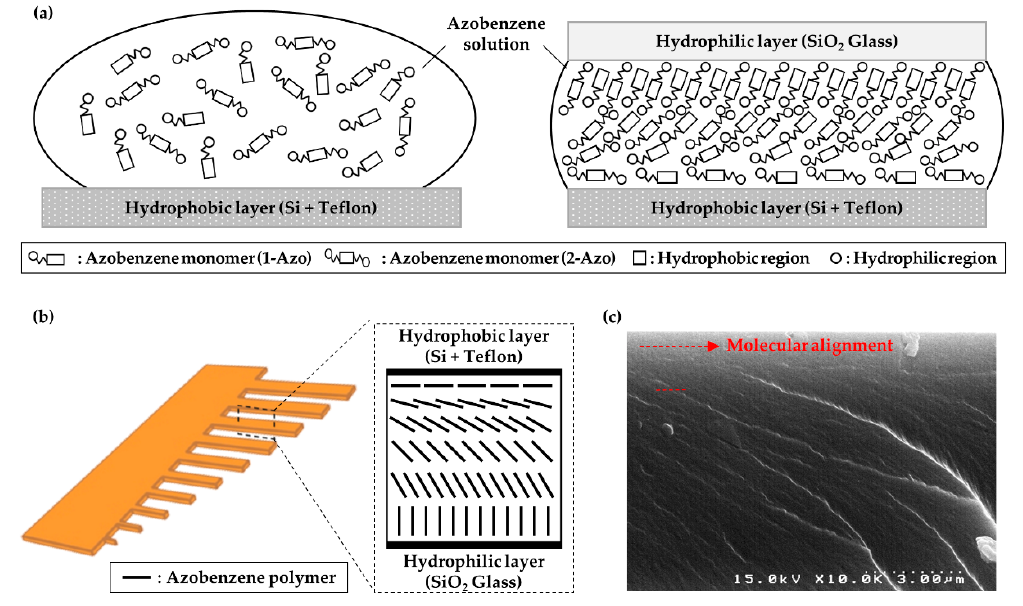
Figure 3. ( a ) Schematics of the interaction between amphiphilic azobenzene monomers and mold surface; ( b ) molecular orientation of the polymerized actuator; and ( c ) cross-sectional scanning electron microscopy image of the actuator; the fracture shows the molecular alignment (red dotted arrow).